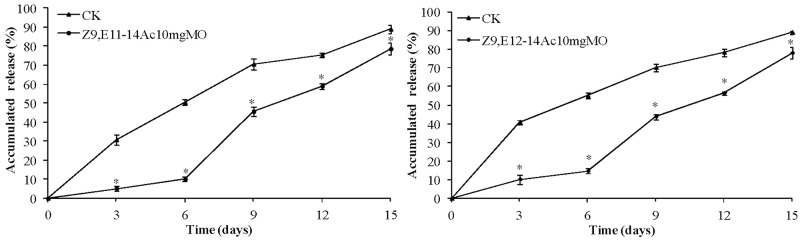
Accumulated release of sex pheromone-loaded MPEG5000-PCL2000 micelles containing controlled-release agents (A) Z9,E11-14:Ac and (B) Z9,E12-14:Ac.Data are expressed as means ± S.D. (n = 3). Asterisks (*) indicate significance (P≤ 0.05).